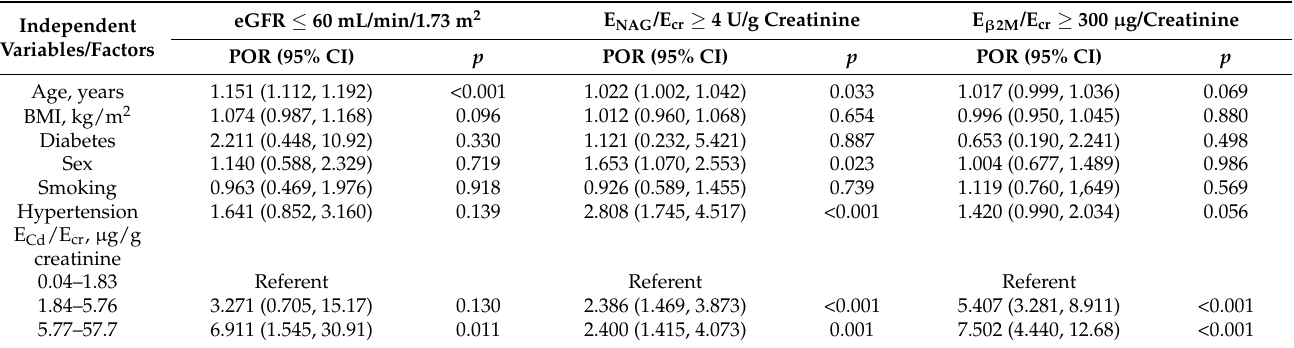
Table 5. Dose–response analysis of E Cd /E cr and the risk of adverse effects on the kidneys.